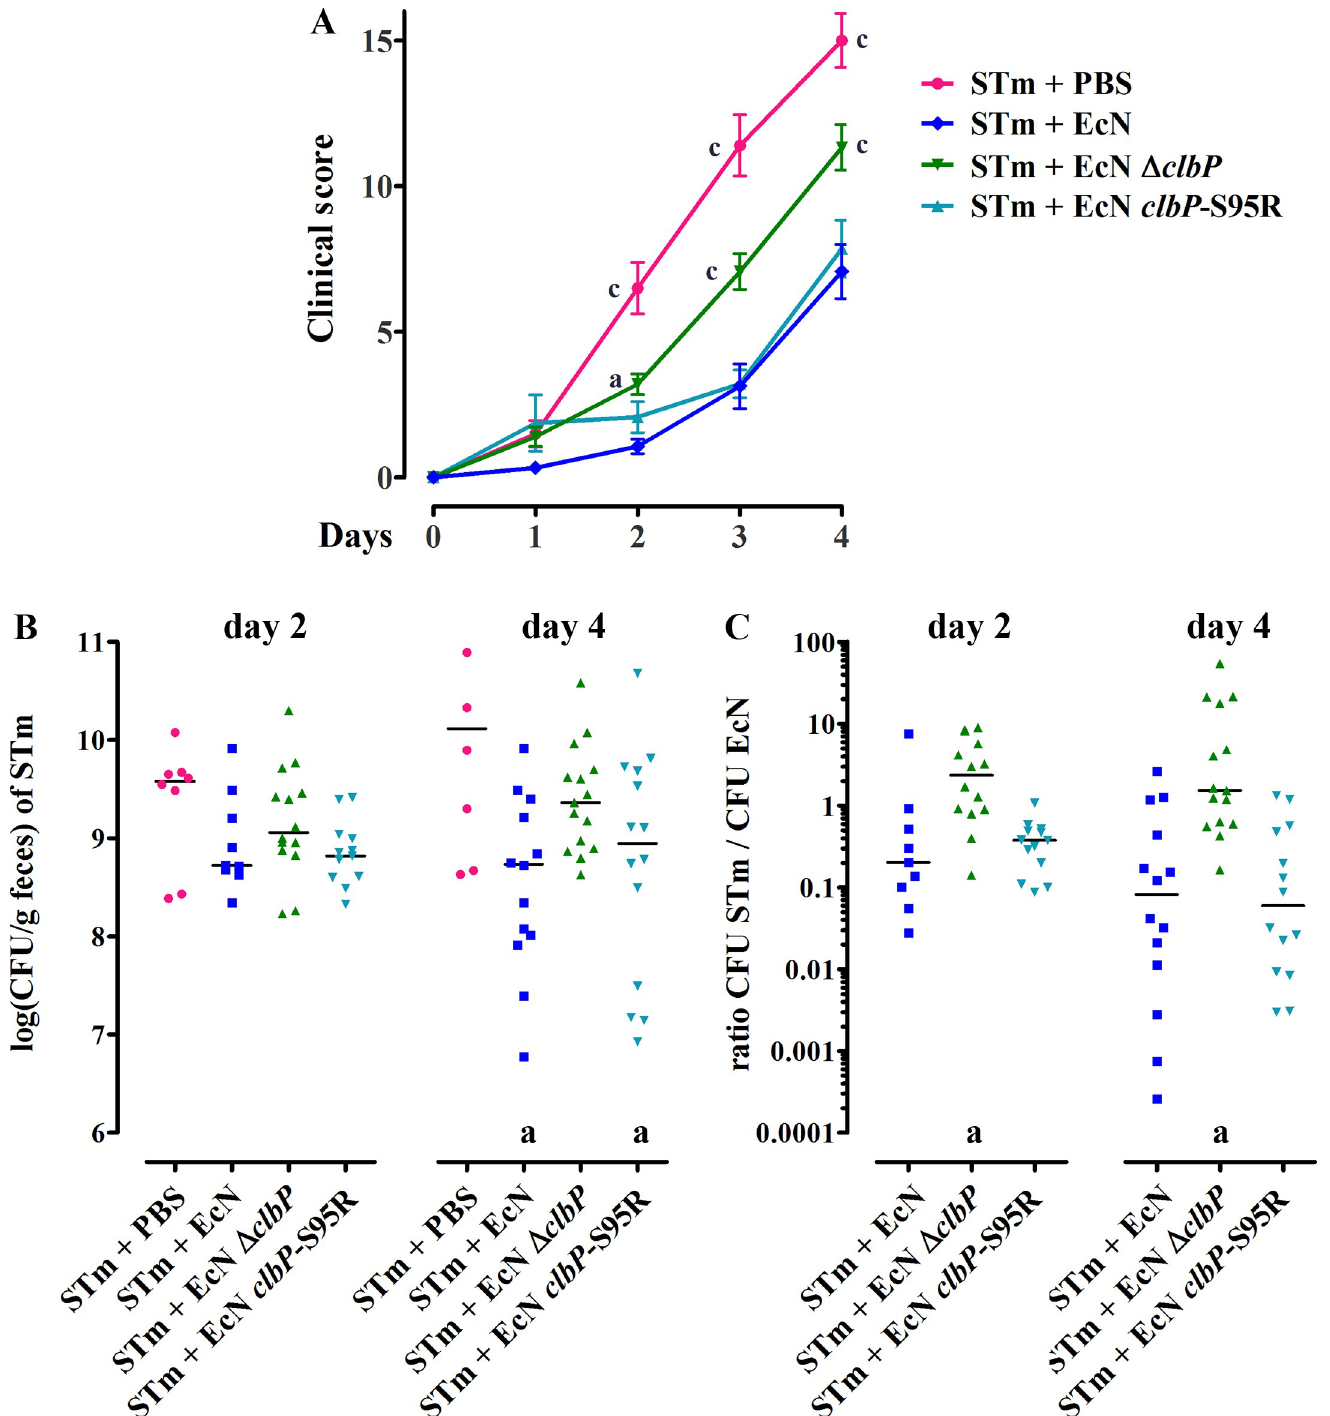
Fig 6. A clbP deletion, but not a genomic point mutation that inactivates ClbP catalytic domain, impairs EcN protection against the enteric pathogen Salmonella Typhimurium in mice. C57BL/6 female mice were treated with 20 mg streptomycin per os , then 24 h later infected orally with 10 9 S . Typhimurium (STm) in PBS or co-administered with 10 9 S . Typhimurium and 10 9 EcN wild-type, Δ clbP or clbP S95R strains. (A) The mice were monitored for clinical signs (weight loss, diarrhea, signs of abdominal pain) daily during 4 days. Each point corresponds to the mean clinical score +/- SEM of 10 to 15 animals per group in three independent experiment. The animals were scored blindly (without knowledge of the infecting bacteria) in two of the three experiments. Two-way ANOVA with Bonferroni post-test compared to STm + EcN, a: p < 0.05, c: p < 0.001. (B) The fecal shedding of STm was examined by enumeration of the feces collected at day 2 and